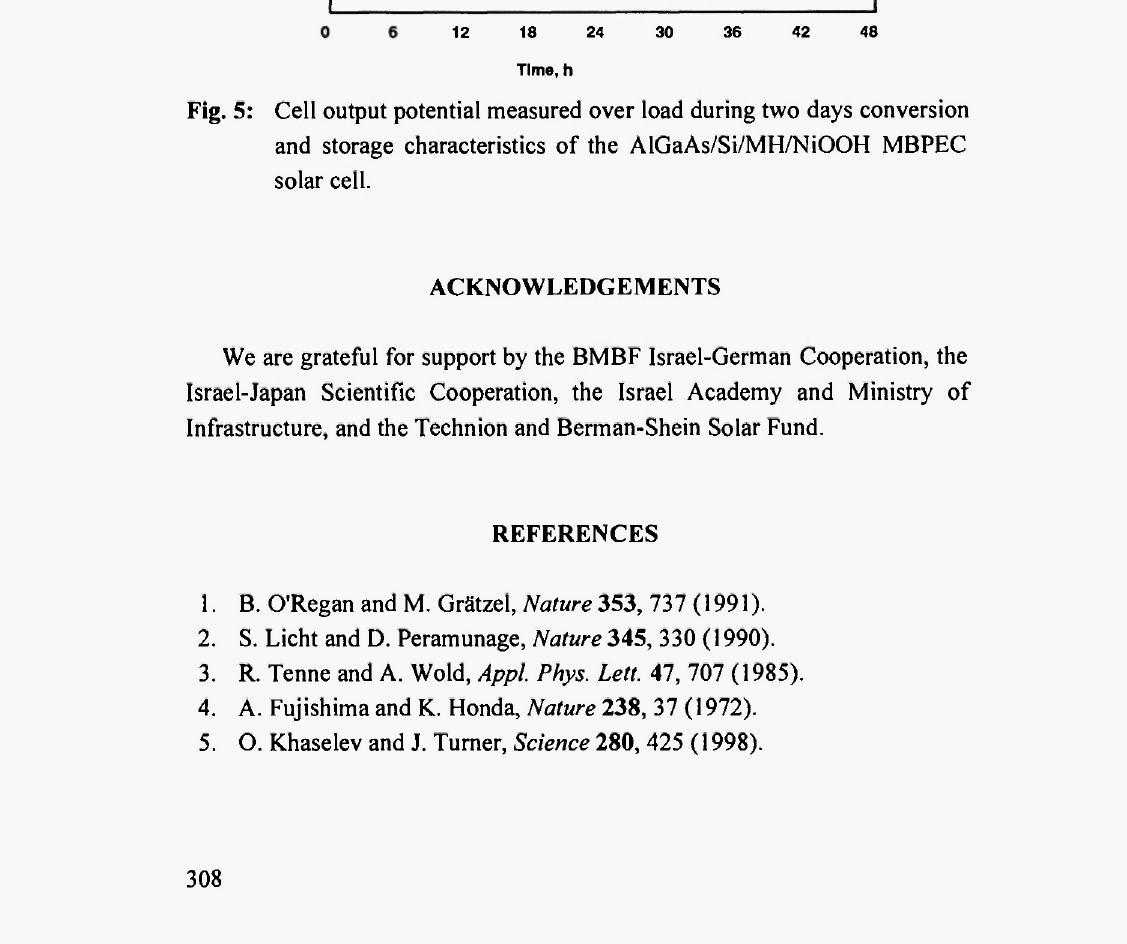
Fig. 5: Cell output potential measured over load during two days conversion and storage characteristics of the AlGaAs/Si/M H/NiOOH MBPEC solar